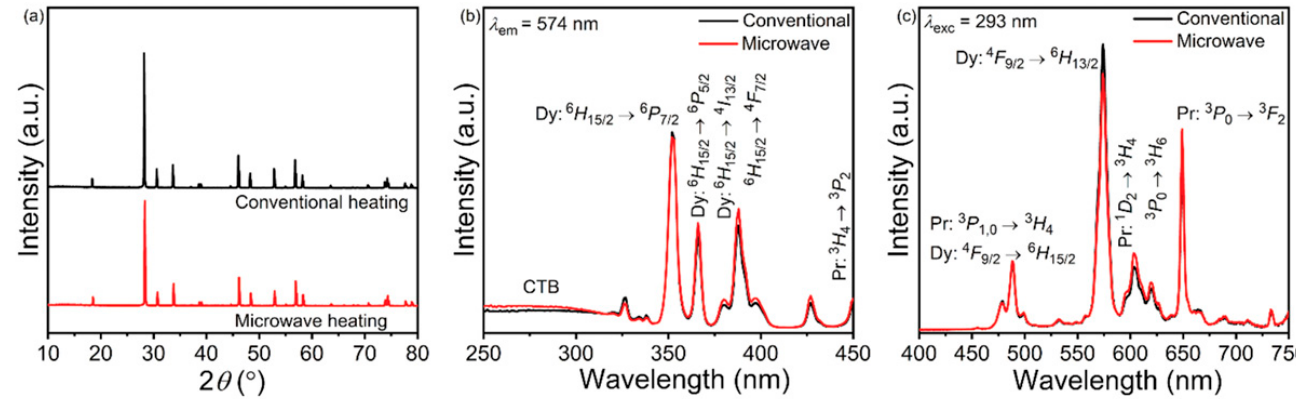
Figure 15. ( a ) XRD patterns, ( b ) excitation spectra, and ( c ) emission spectra of quinary molybdate phosphors NaLa 0.95 Pr 0.025 Dy 0.025 (MoO 4 ) 2 synthesized using conventional and microwave heating. Reproduced from ref. [121] with permission from The Royal Society of Chemistry.